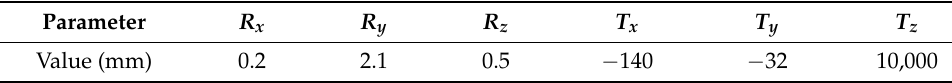
Table 7. Real pose between the TCS and the BCS in simulations.